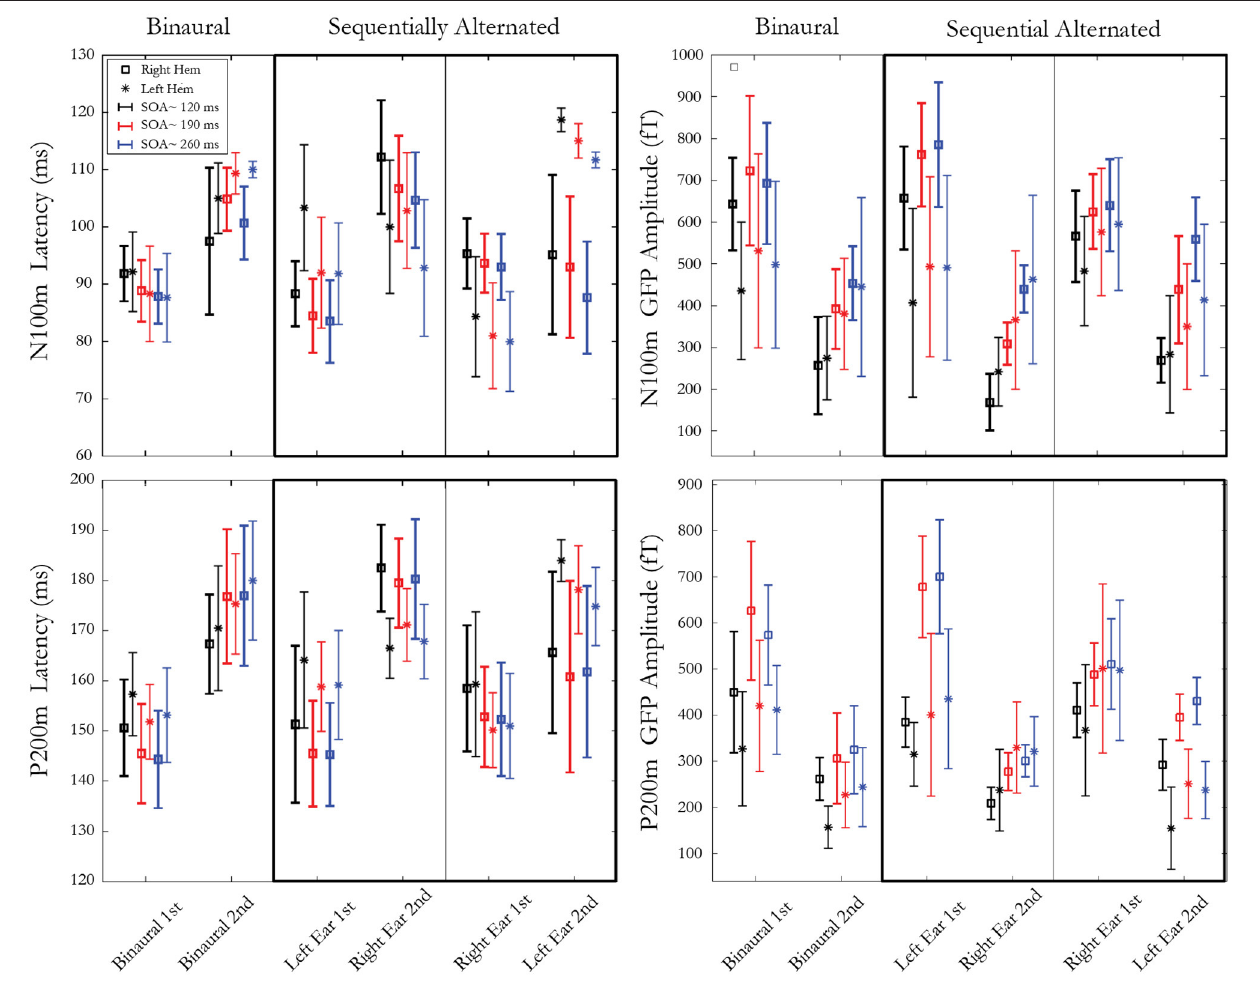
FIGURE 3 | Latencies ( left ) and amplitudes ( right ) of mGFP N100m ( top ) and P200m ( bottom ) components. Each panel represents 3 presentation conditions: 1 binaural condition and 2 sequentially alternated conditions (stimulus presented first at either left or right ear). Within each presentation condition, three SOAs ( ∼ 120 ms, ∼ 190 ms and ∼ 260ms) are used, resulting in two responses to both stimuli of the pair, recorded from both right and left hemispheres. Error bars denote standard deviations between participants.